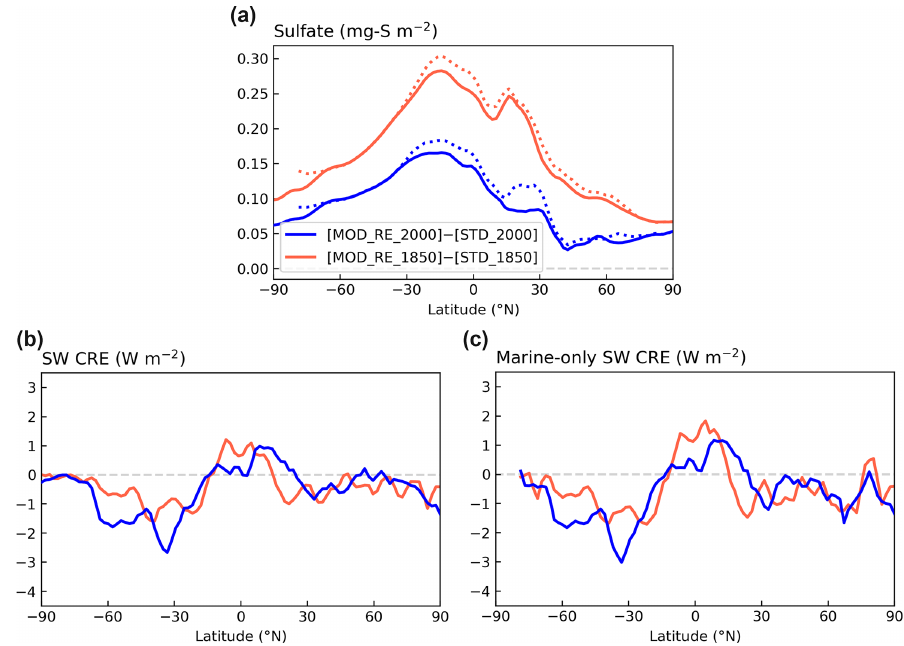
Figure 12. Contrasting the zonal means of changes in (a) sulfate column concentration, (b) SW CRE, and (c) marine-only SW CRE modeled with [MOD_RE] and [STD] chemistry for PI and PD simulations. Dotted lines in panel (a) show the zonal mean marine grid cells only.